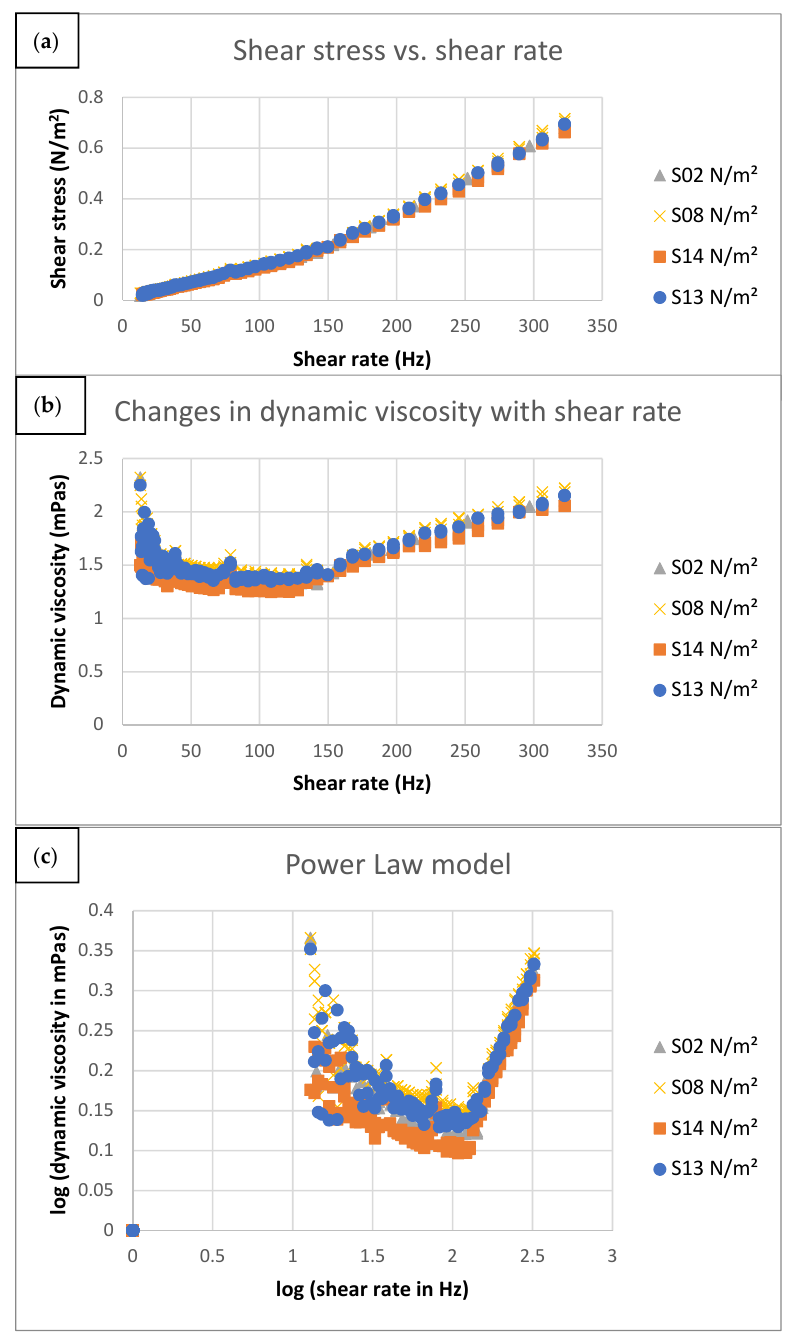
Figure 4. Rheological test results of the S02, S08, S13, and S14 samples: ( a ) flow curve, ( b ) dynamic viscosity changes, ( c ) power law model. 2.4. FTIR The FTIR spectra were recorded with air or water as the background. Both series of